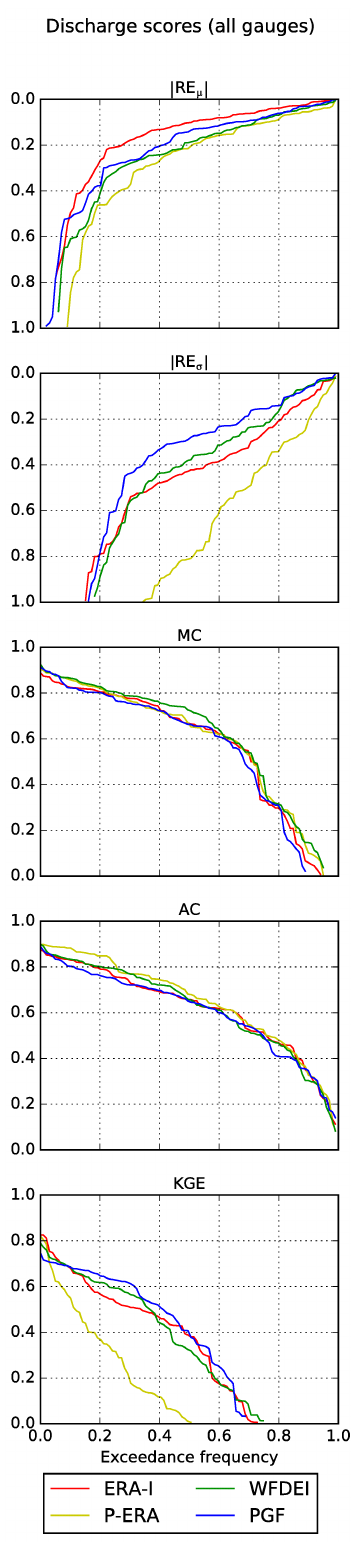
Figure 7. Cumulated frequency plots of river discharge scores com- puted at all GRDC gauges. |RE µ | and |RE σ | values larger than 1 are not shown. MC, AC and KGE are truncated at